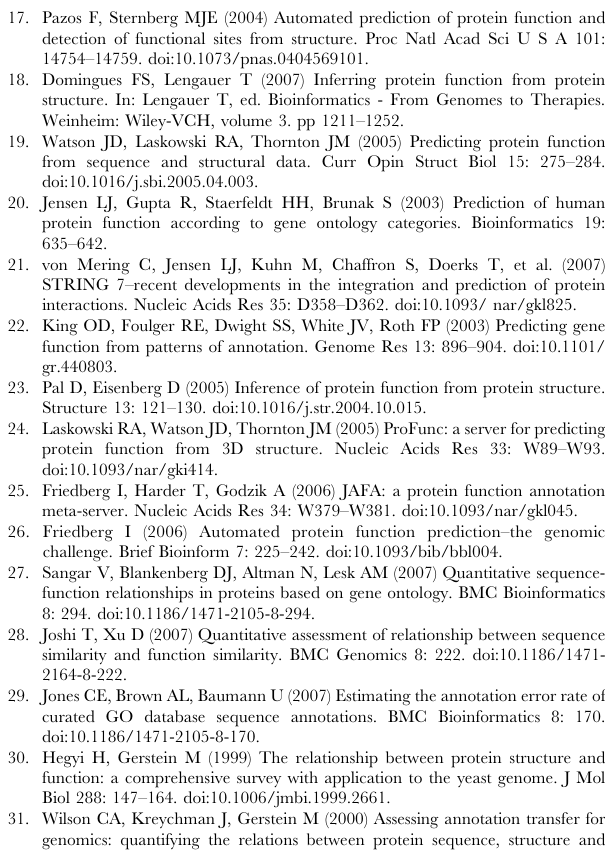
Table S1 Details on Application to Structural Genomics Proteins. The table provides details on the 49 cases described in the paper, including PDB identifiers. Found at: doi:10.1371/journal.pcbi.1000105.s001 (0.06 MB PDF) Text S1 Significance Analysis. Additional evaluation of the significance of the findings, based on an extended ROC-analysis / cross-validation Figure S1 Performance assessment of consensus combination vs. selective combination. We use precision-recall graphs to compare the different predictors resulting from consensus score combina- tion and selective score combination with predictors employing mere protein similarity measures and a background predictor. The plot is based on the cross-validation results, each curve describing the median performance of one distinct predictor. The boxes indicate 25% and 75% quantiles, the whiskers represent the maximum deviation from the median. The predictors employing protein similarity measures only, have a performance worse than the background predictor for very low recall rates. For very similar